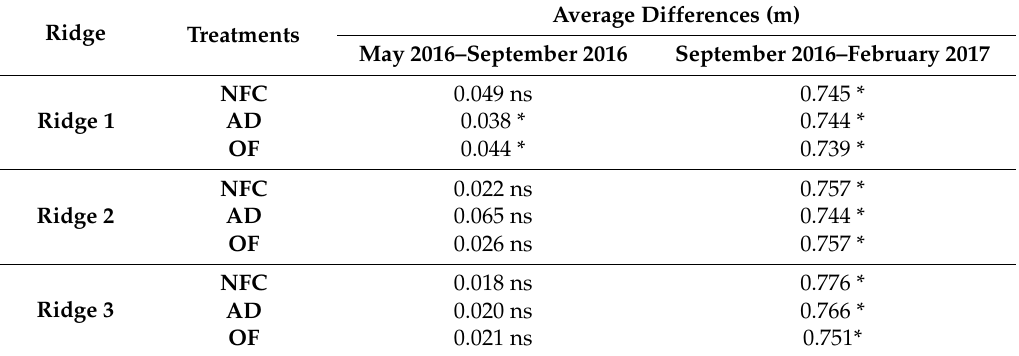
Table 2. Average differences between the mean elevation values for each ridge considering the different treatments (OF, organic fertilizer; AD, anaerobic digestate fertilizer; NFC, unfertilized control) and the results of the Mann-Whitney